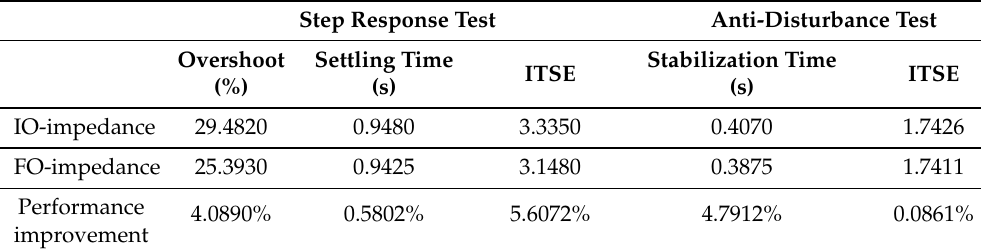
Table 1. Comparison of simulation performance between FO/IO-impedance controller.